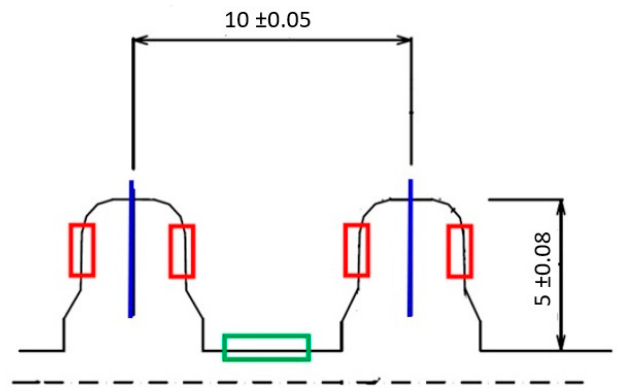
Figure 2. Parameters of the blank showing the tooth height 5 ± 0.08 mm and the tooth spacing 10 ± 0.05 mm (own study).